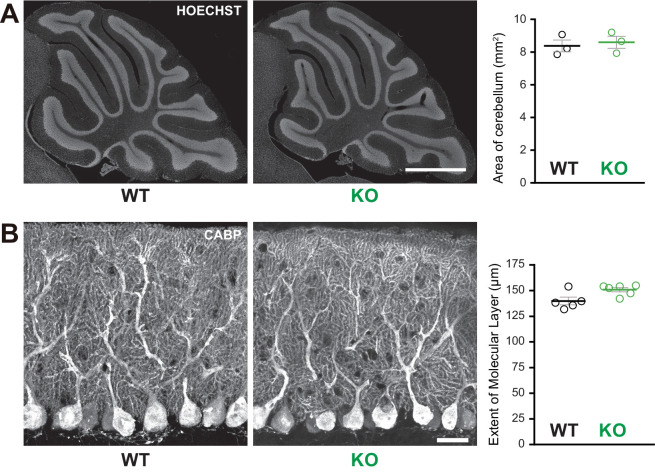
Normal cerebellar cytoarchitecture in Susd4 knockout (KO) mice.(A) Parasagittal sections of P30 Susd4 wild-type (WT and Susd4 KO cerebella were stained with Hoechst and used for quantitative analysis of the mean area of the cerebellum). Mean ± s.e.m. (n = 3 WT mice and n = 3 KO mice). Scale bar 500 µm. (B) Calbindin protein (CABP) immunostaining was used for quantitative analysis of the mean height of the molecular layer. Mean ± s.e.m. (WT n = 5 and KO n = 6 mice). Scale bar 30 µm.